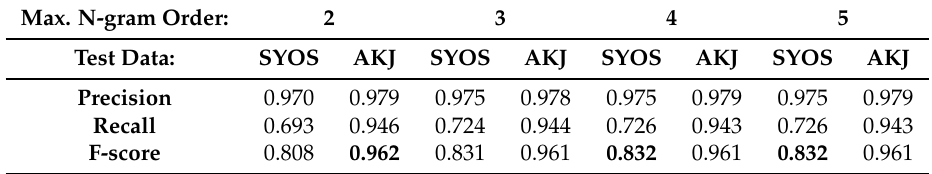
Table 7. Evaluation results—model with Kneser-Ney smoothing (best results in bold).